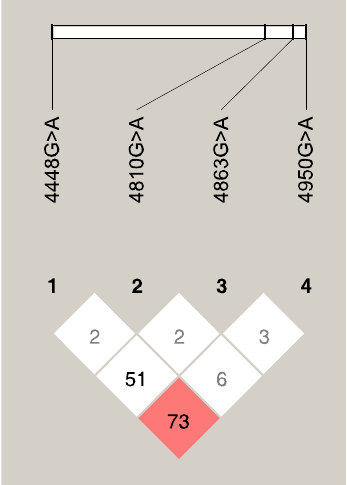
Figure 1. Linkage disequilibrium plot of four RNF213 single nucleotide polymorphisms. The linkage disequilibrium between each single nucleotide polymorphism (SNP) is measured as the D' statistic (× 100), shown in the diamond at the intersection of the diagonals of the two corresponding SNPs. Strong linkage disequilibrium is represented in red, and weak linkage disequilibrium is represented in white.